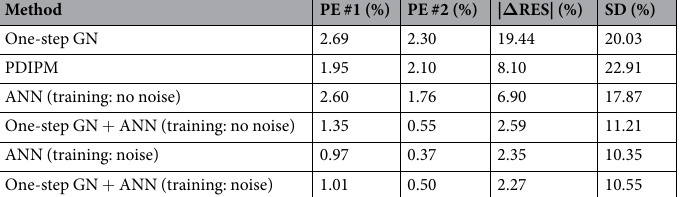
Table 1. PE, | Δ RES| and SD errors obtained for reconstruction from phantom data with different methods. Corresponding images are shown in Fig. 2. Target #1 is located on the left side and target #2 is located on the right side of the